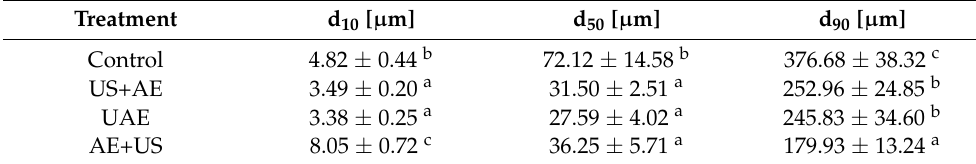
Table 2. The particle size of dispersions after alkaline